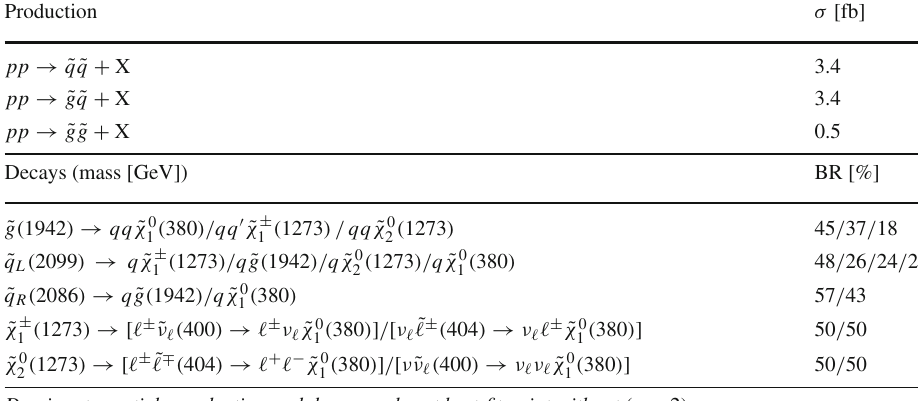
production and decay modes for various pMSSM11 parameter sets. Top panel: best-fit point with ( g − 2 ) μ . Second panel: representative point in the ‘nose’ region in fit with ( g − 2 ) μ . Third panel: best-fit point without ( g − 2 ) μ . Bottom panel: representative point in the ‘nose’ region in fit without ( g − 2 )